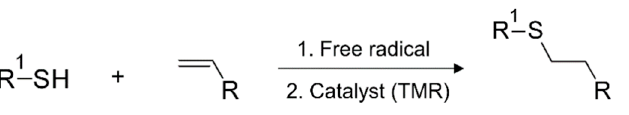
Figure 21. General reaction scheme of the addition of thiols across “ene” functions: radical mediated thiol-ene versus catalyzed thiol-Michael reaction (TMR) [225].